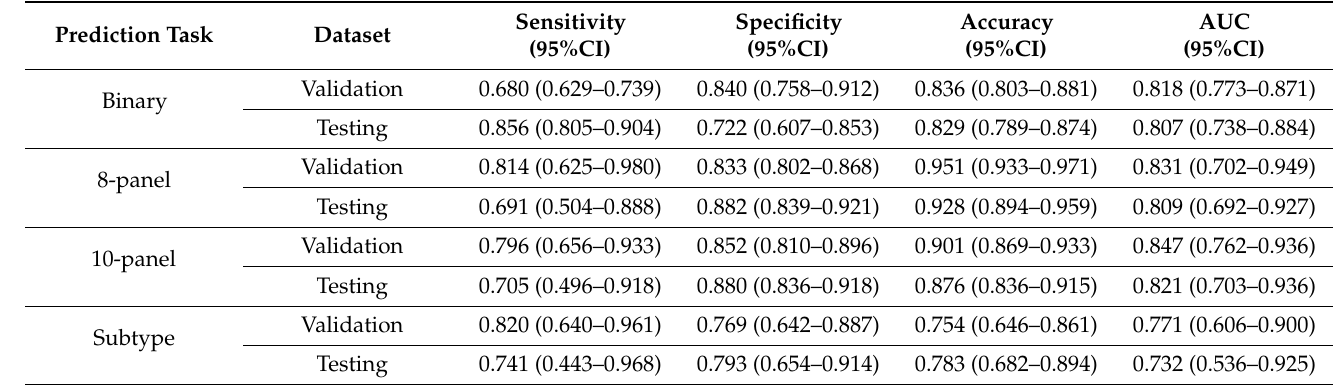
Table 1. Predictive performance of radiomics model.